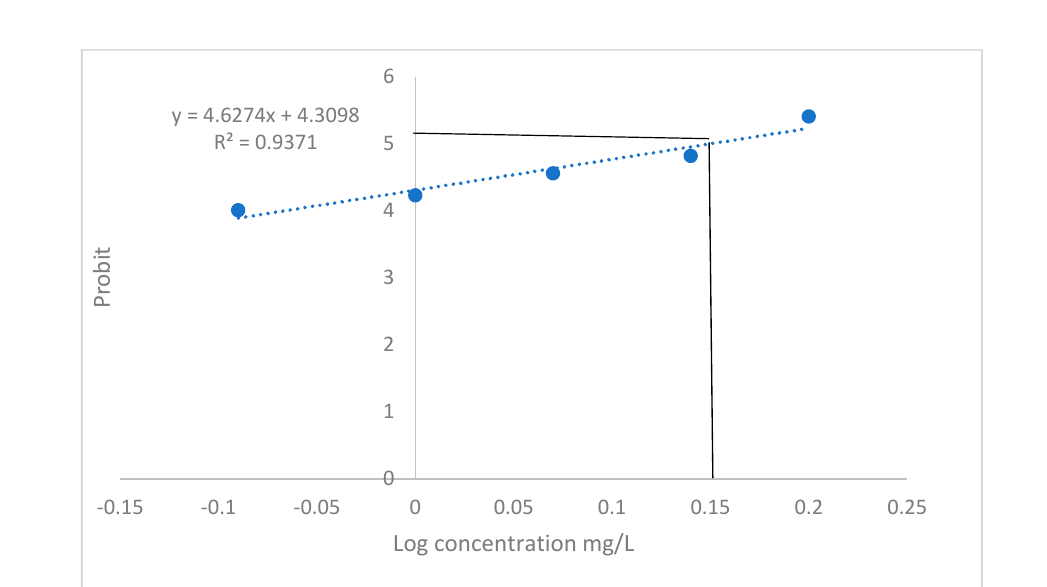
Figure 1. Logarithmic probit line to determine the 96 h LC 50 of detergent NTL exposed to the fish.